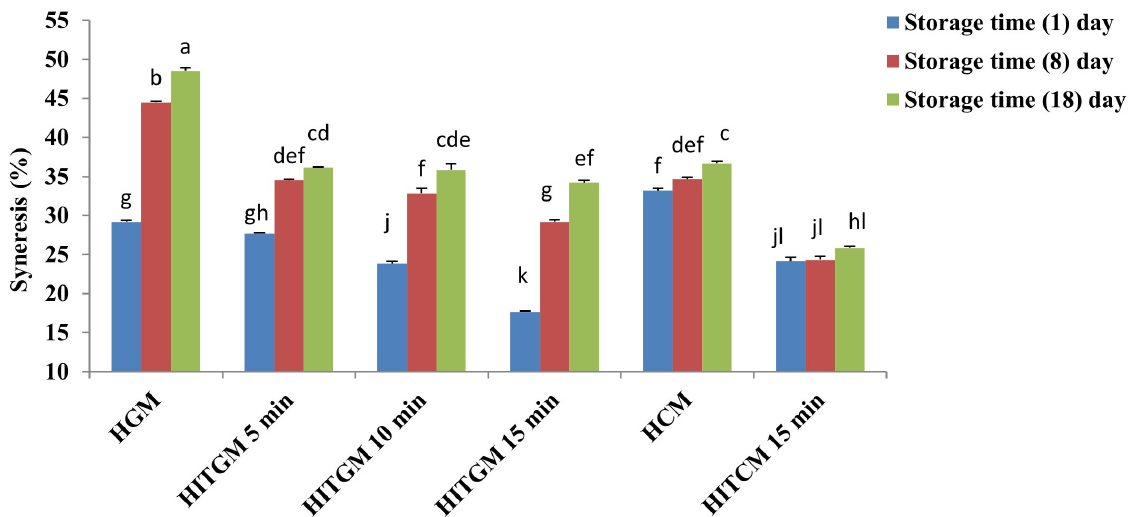
Figure 3. Syneresis of the stirred yoghurt samples during storage. HGM, homogenized goat milk; HITGM 5 min, goat milk, high-intensity thermosonicated for 5 min; HITGM 10 min, goat milk, high-intensity thermosonicated for 10 min; HITGM 15 min, goat milk, high-intensity thermosonicated for 15 min; HCM, homogenized cow milk; HITCM 15 min, cow milk, high-intensity thermosonicated for 15 min. Data points not connected by the same letter are significantly different from each other ( p <